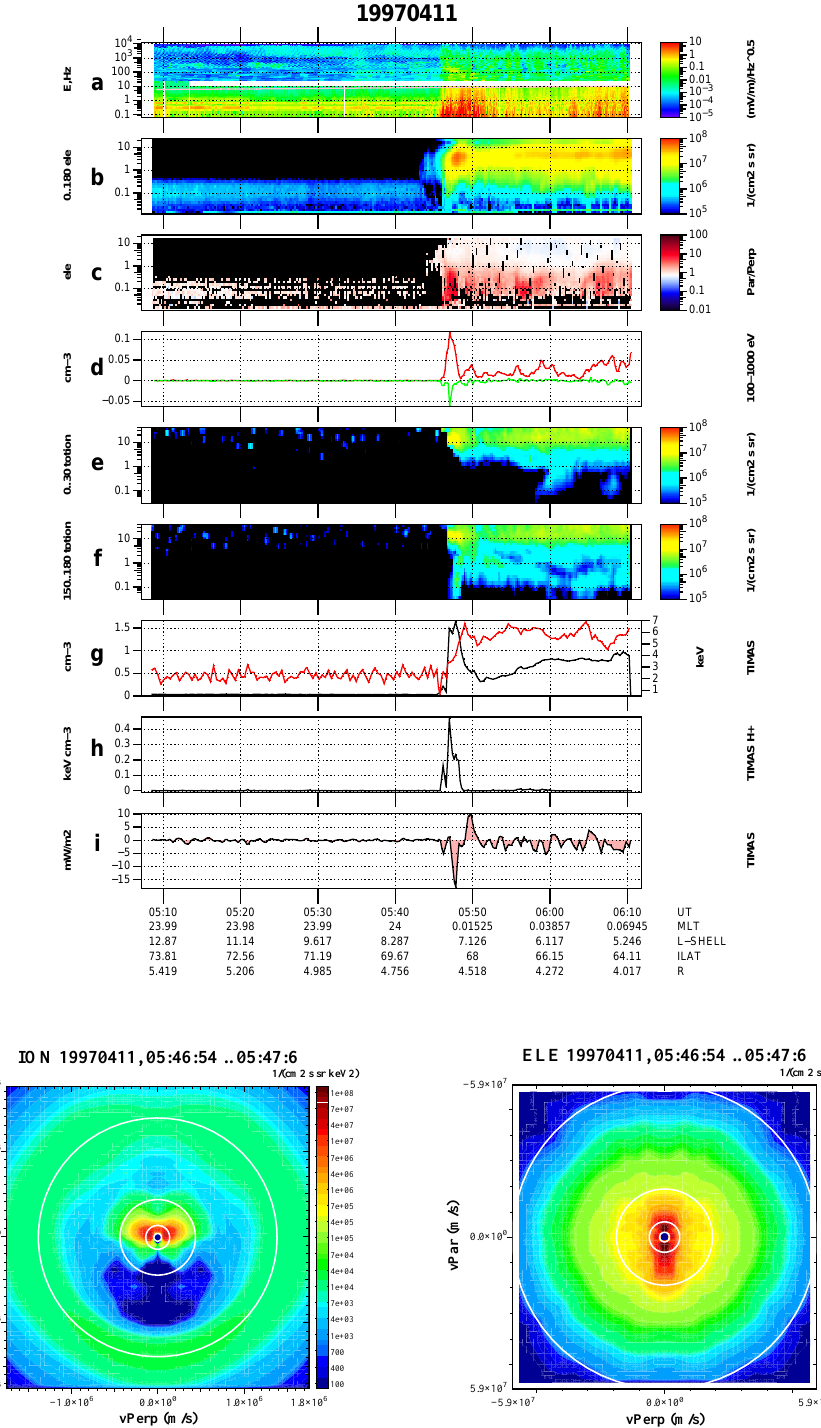
Fig. 11. Example of an event containing a half-consumed shell distribution (i.e. downgoing part is intact but upgoing part has been flattened out). In all PSBL events we have looked at there is always an upgoing ion beam embedded within the shell. Format is similar to Fig. 9 except that in panel (a), PWI wave data spectrogram has been added at frequencies 26Hz–10kHz in addition to the standard EFI spectrogram below 10Hz. One-count level is 300 times smaller than shell